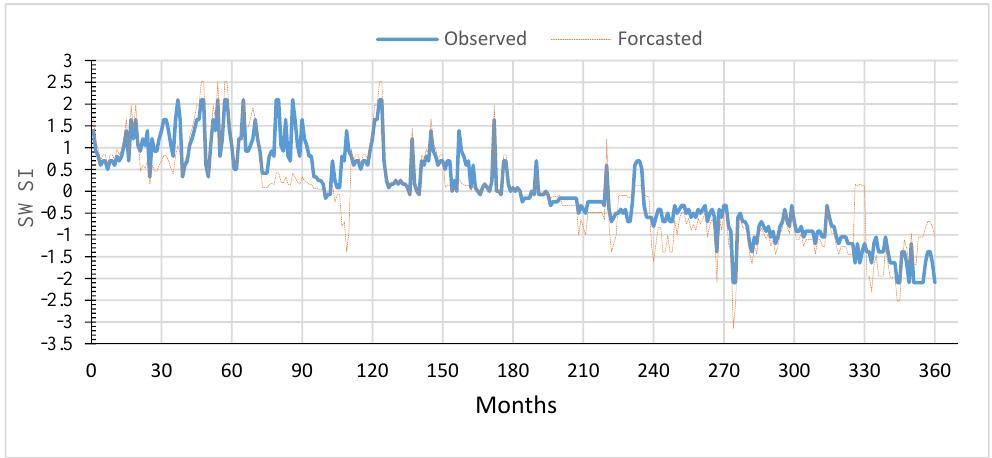
Figure 12. SWSI observed and forecasted values (360 months) of station 1 for input model number 3.